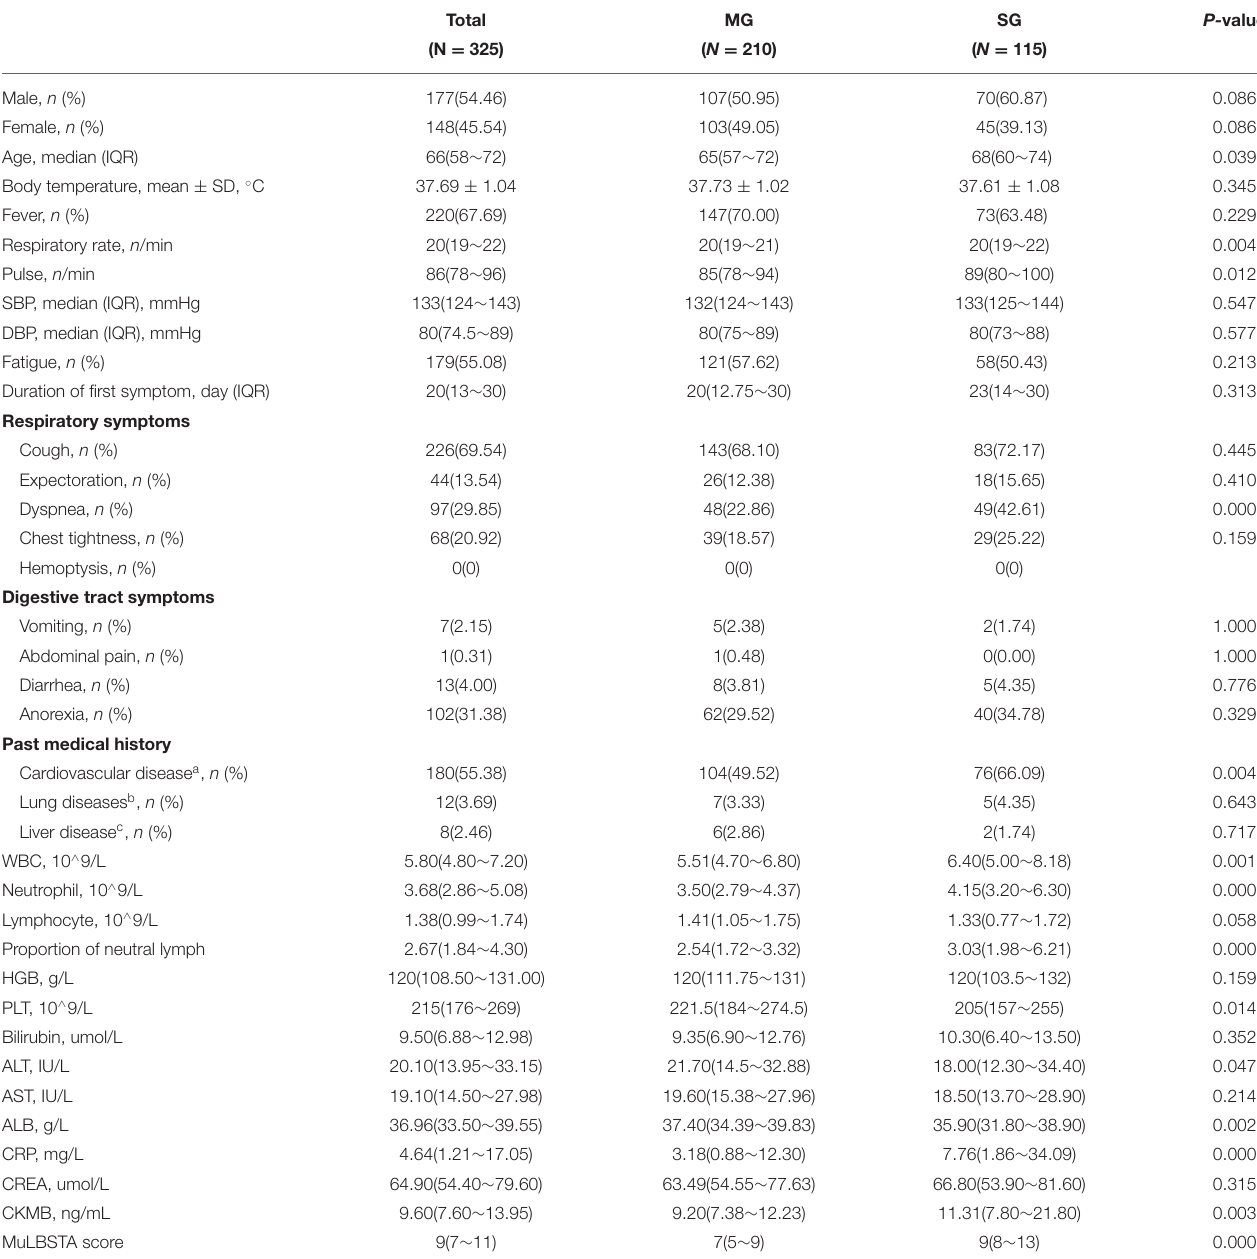
TABLE 2 | Univariate analysis of severity-related factors in diabetic patients with COVID-19, ( N = 325). Total MG SG P- value (N =